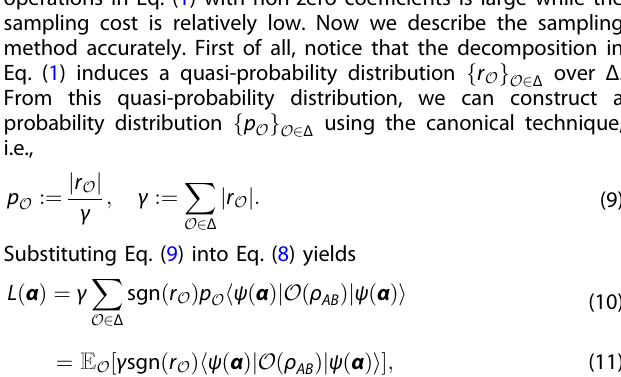
Algorithm 1 . Deterministic VED 1: Input: 2 n -qubit quantum state ρ AB , decomposition in Eq. (1)